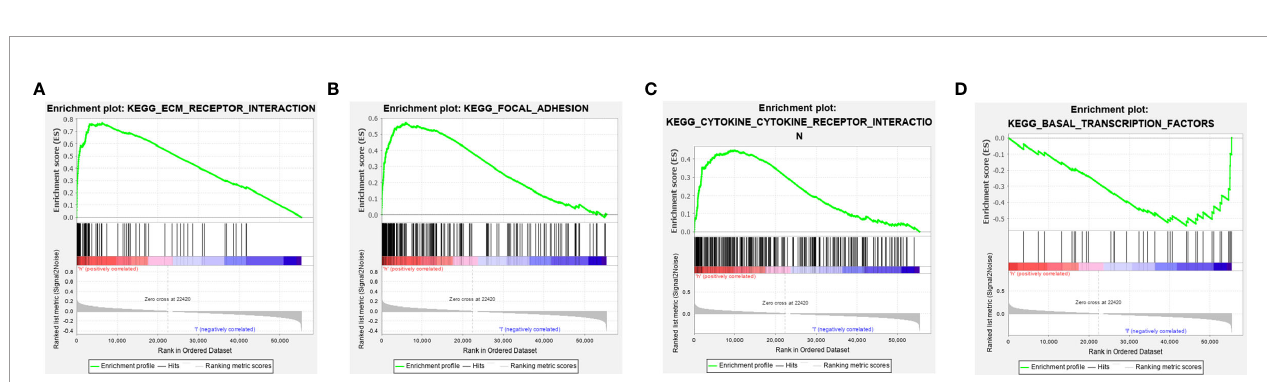
FIGURE 7 | Gene set enrichment analysis (GSEA) of the m6A-related lncRNA signature in the high-risk group (A – C) and low-risk group (D) , respectively.